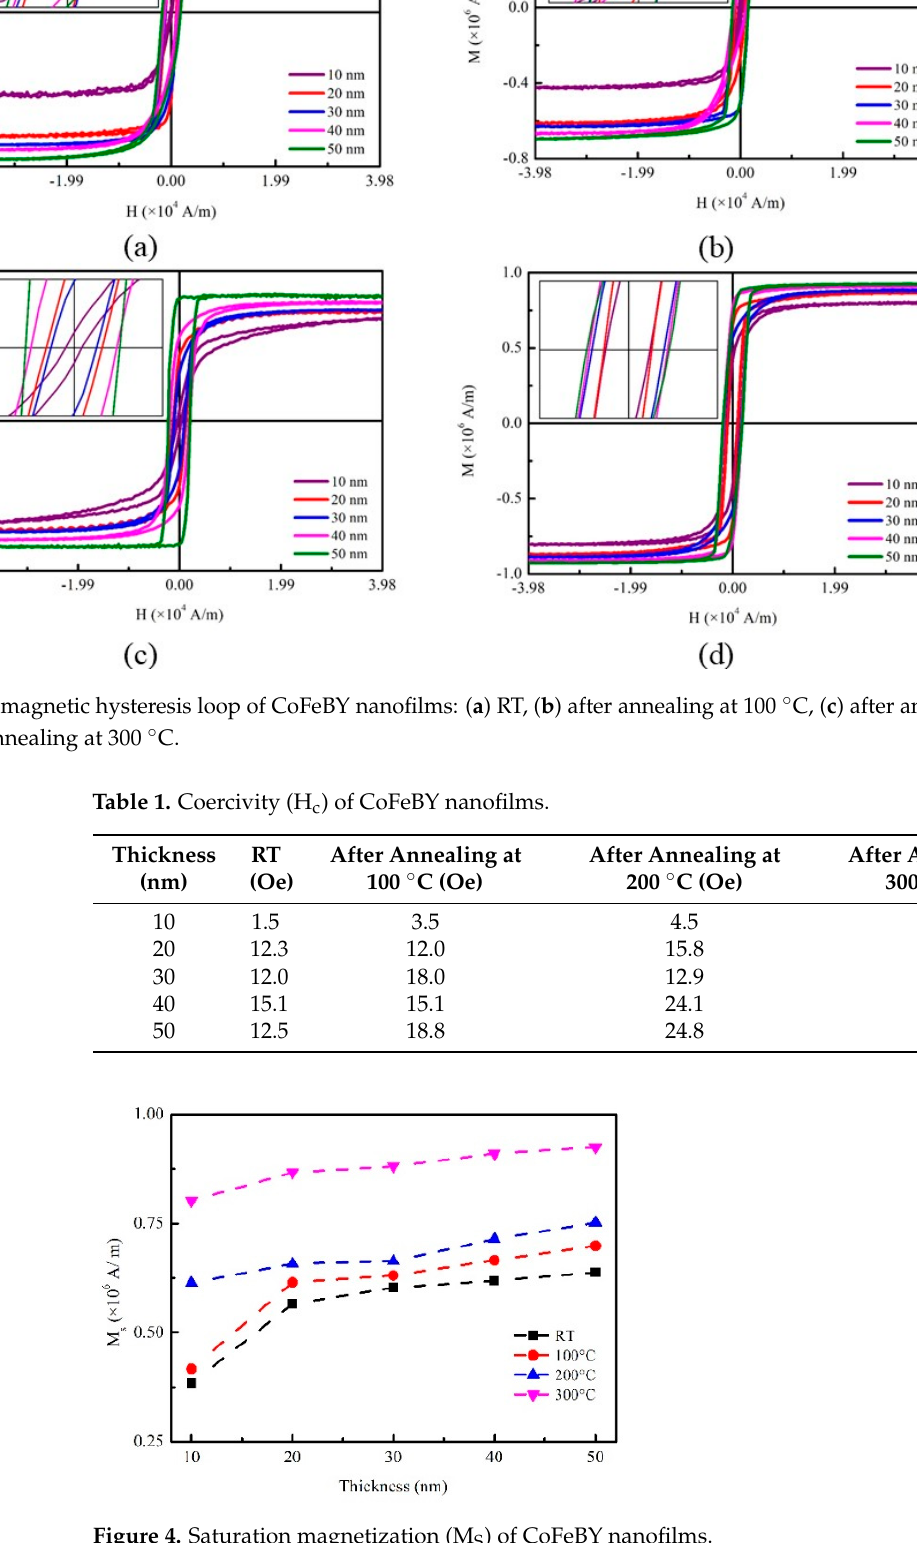
Figure 4. Saturation magnetization (M S ) of CoFeBY nanofilms.